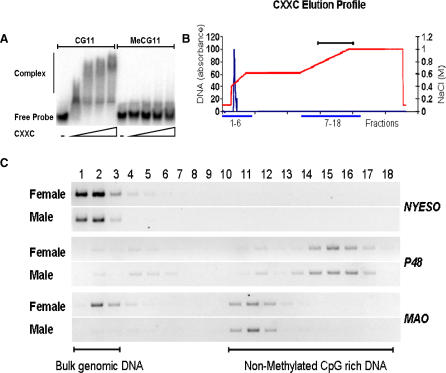
The Immobilised CXXC Domain Specifically Retains DNA Containing Clusters of Nonmethylated CpGs(A) EMSA showing the CXXC complex with a DNA probe containing 27 nonmethylated CpG sites. Nonmethylated probe DNA (CG11) or methylated probe (MeCG11) was incubated with 0, 250, 500, 1,000, or 2,000 ng of recombinant CXXC protein.(B) A typical elution profile of bulk genomic DNA (blue line) from a CXXC affinity chromatography column. Genomic DNA (100 μg) was applied to the CXXC affinity matrix (see Methods) in low salt (0.1 M NaCl) and eluted with a gradient of increasing NaCl (red line; see text). Eighteen fractions were interrogated by PCR (blue lines). The bracket above indicates fractions that were found to contain nonmethylated CGIs.(C) Elution of specific CGI sequences of known methylation status. Methylated CGIs (NYESO and MAO in females) coelute with bulk genomic DNA (see bracket) whereas nonmethylated CGIs (P48 and MAO) elute at high NaCl concentration.